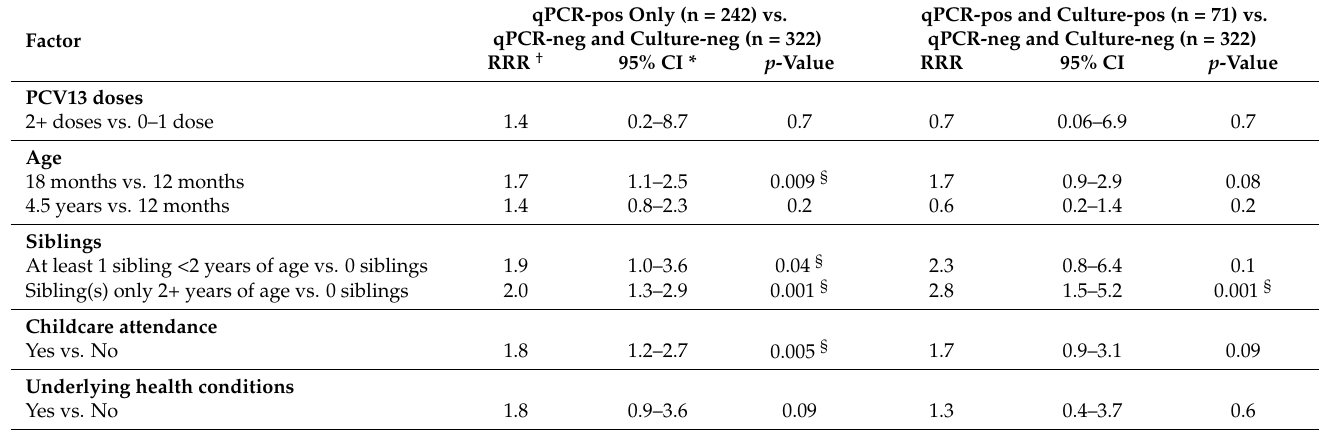
Table 2. Multinomial Logistic Regression of Clinical Factors Associated With S. pneumoniae Carriage Detected by qPCR and Culture Methods or qPCR Only Compared to Culture and qPCR negative.